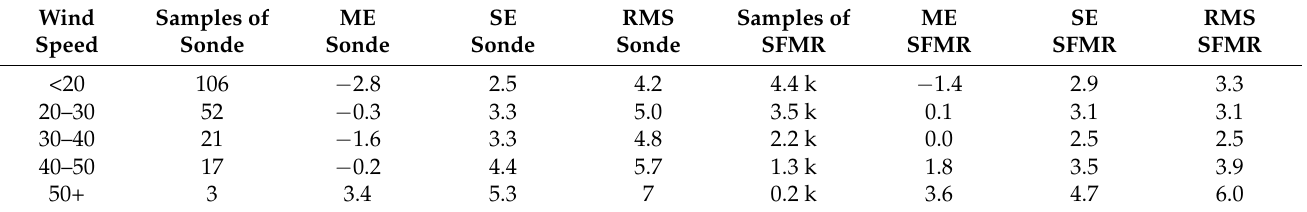
Table 5. HIRAD difference statistics with dropsonde and SFMR (reference–HIRAD) m/s as a function of binned wind speed, where the binning is in respect to the reference. The mean error (ME), standard error (SE), and root mean squared error (RMSE) are given for each.